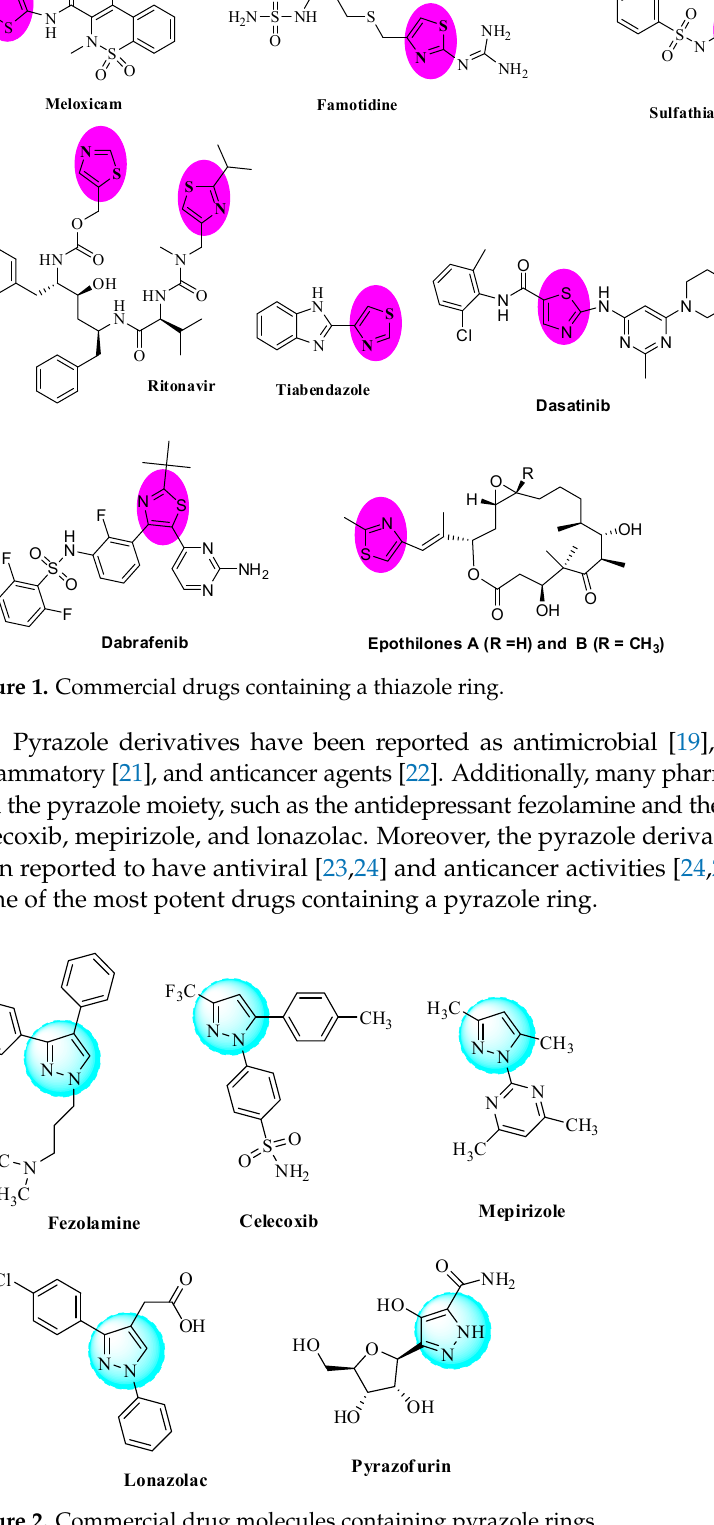
S NN N Figure 3. Pharmacologically active pyrazolo[5,1- b ]thiazole derivatives. Hydrazides are an important class of biologically active compounds [34–38]. Hydra- zides and their condensation products have been reported to possess a wide range of pharmacological and biological activities, including antibacterial [34], tuberculostatic [35], HIV inhibitory [36], pesticidal [37], and antifungal [38] activities. Some of them are used as monoamine oxidase (MAO) inhibitors and serotonin antagonists in psychopharmacol- ogy [39]. Furthermore, isonicotinoyl hydrazide (isoniazid) is an excellent antituberculosis